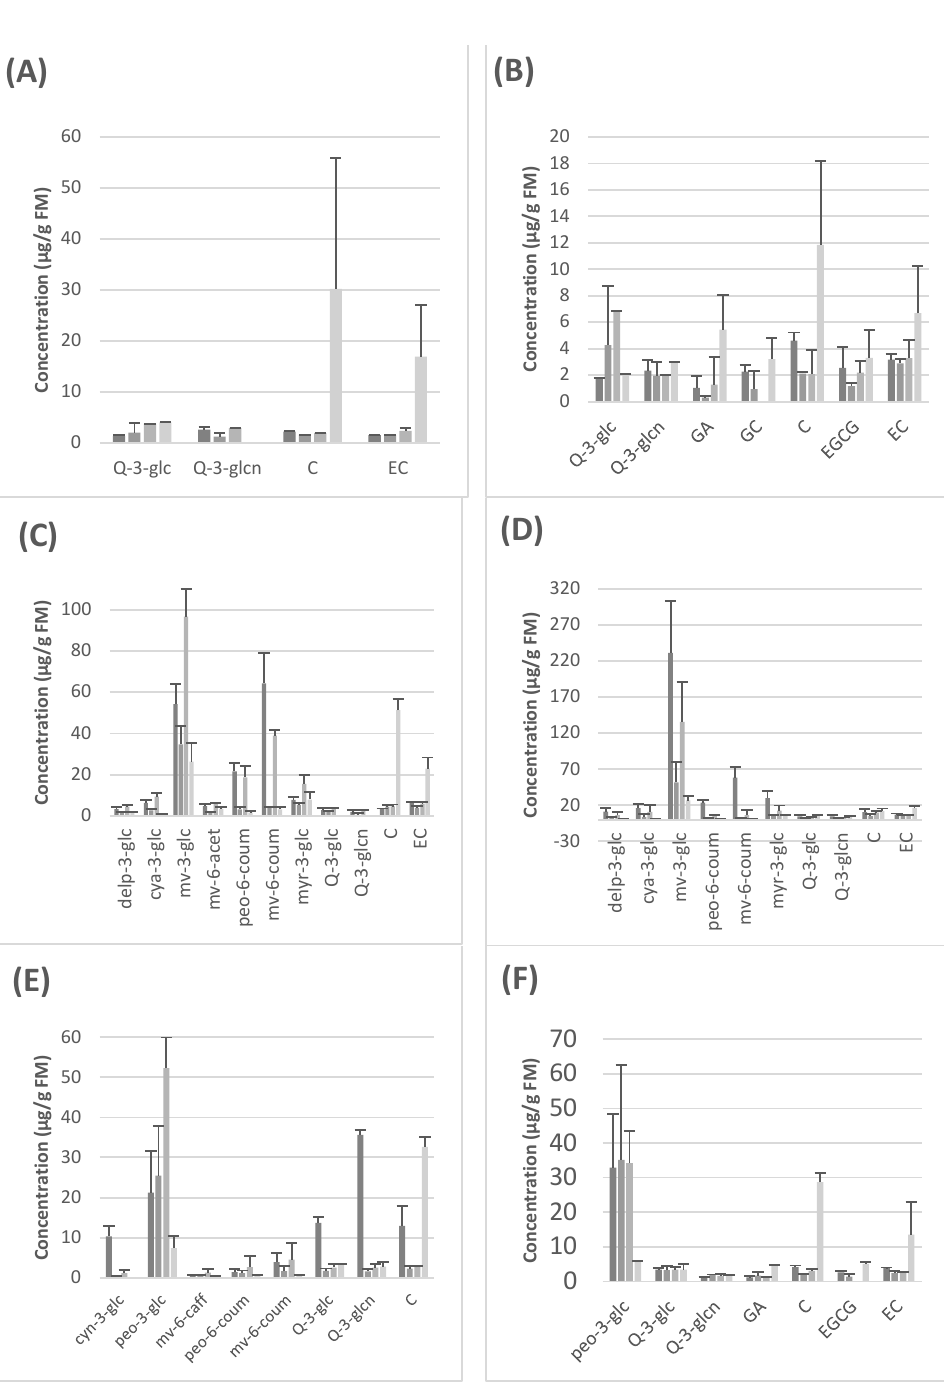
Figure 1. Concentrations of the most representative compound in each seedless grape at each stage of digestion. ( A ) Autumn Crisp, ( B ) Pristine, ( C ) Adora, ( D ) Melody, ( E ) Scarlotta, ( F ) Crimson. ■ Raw material, ■ Oral phase, ■ Gastric phase, ■ Intestinal phase. FW: fresh weight, Delp-3-glc: delphinidin-3-glucoside, cya-3-glc: cyanidin-3-glucoside, mv-3-glc: malvidin-3-glucoside, mv-6-acet: malvidin-3-(6-acetylglucoside), mv-6-caff: malvidin-3-(6-caffeoylglucoside), peo-6-coum: peonidin-3-(6-coumaroylglucoside), mv-6-coum: malvidin-3-(6-coumaroylglucoside), myr-3-glc: myricitin-3-glucoside, Q-3-glc: quercetin-3-glucoside, Q-3-glcn: quercetin-3-glucoronide, GA: gallic acid, GC: gallocatechin, C: catechin, EGCG: epigallocatechin, EC: epicatechin. Data expressed as mean + standard error bar.